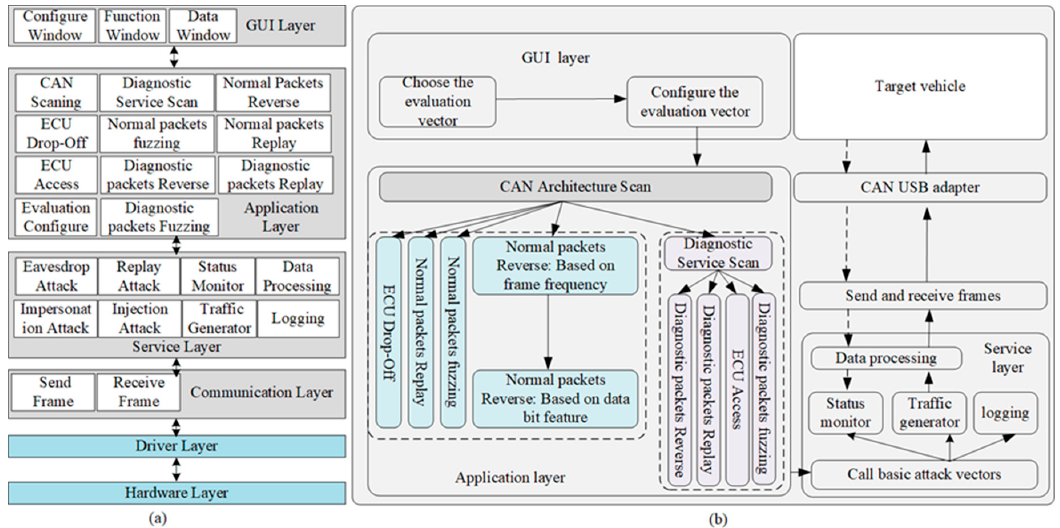
Figure 4. CANsec architecture: ( a ) The framework of CANsec; ( b ) Automatic evaluation flow.